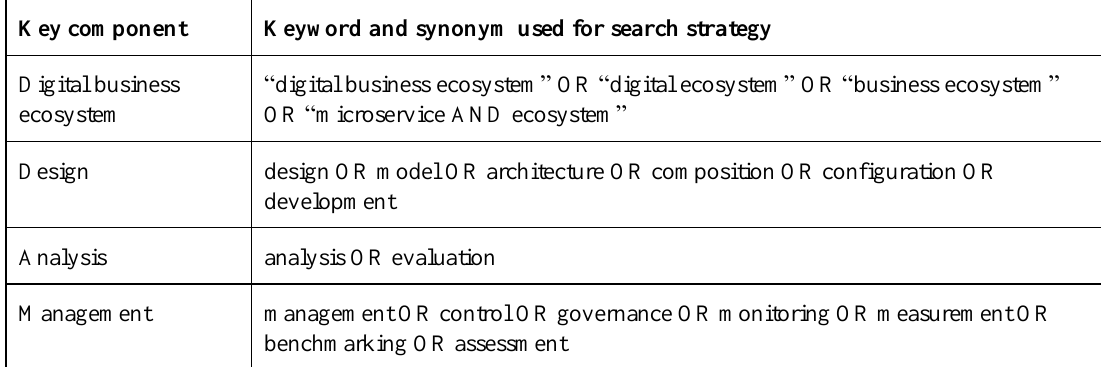
Table 2. Key components and the matching keywords used for developing search strategy Key component Keyword and synonym used for search strategy